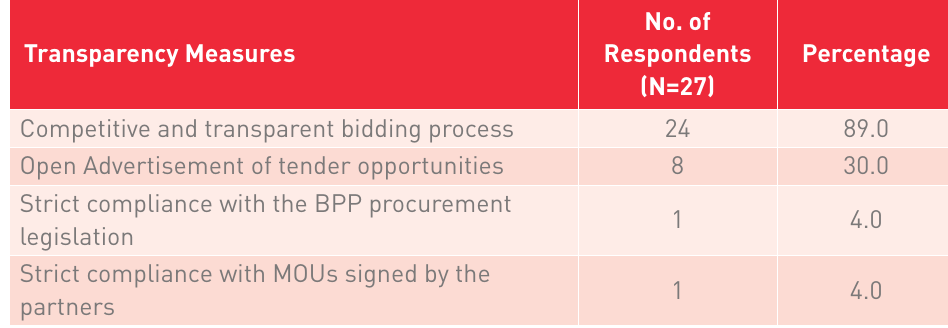
Summary of Transparency Measures in PPP Housing